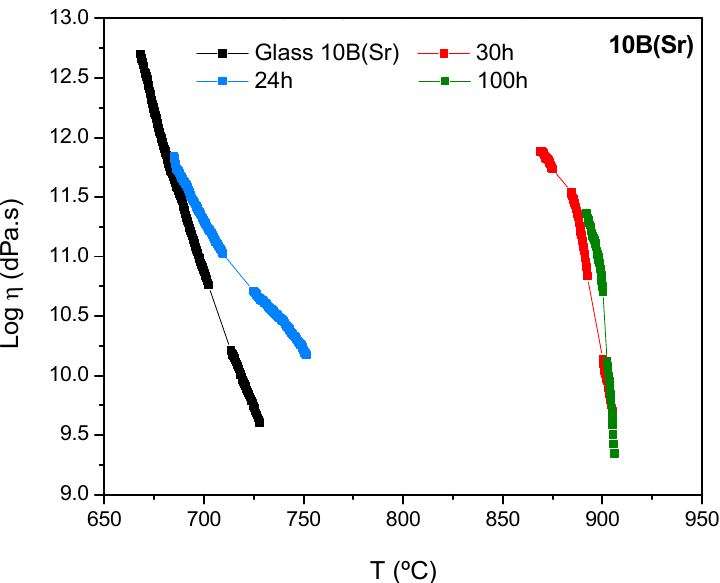
Figure 9. Viscosity of the 10B(Sr) glass-ceramics as a function of the crystallization degree. Treatment temperature 750 °C.